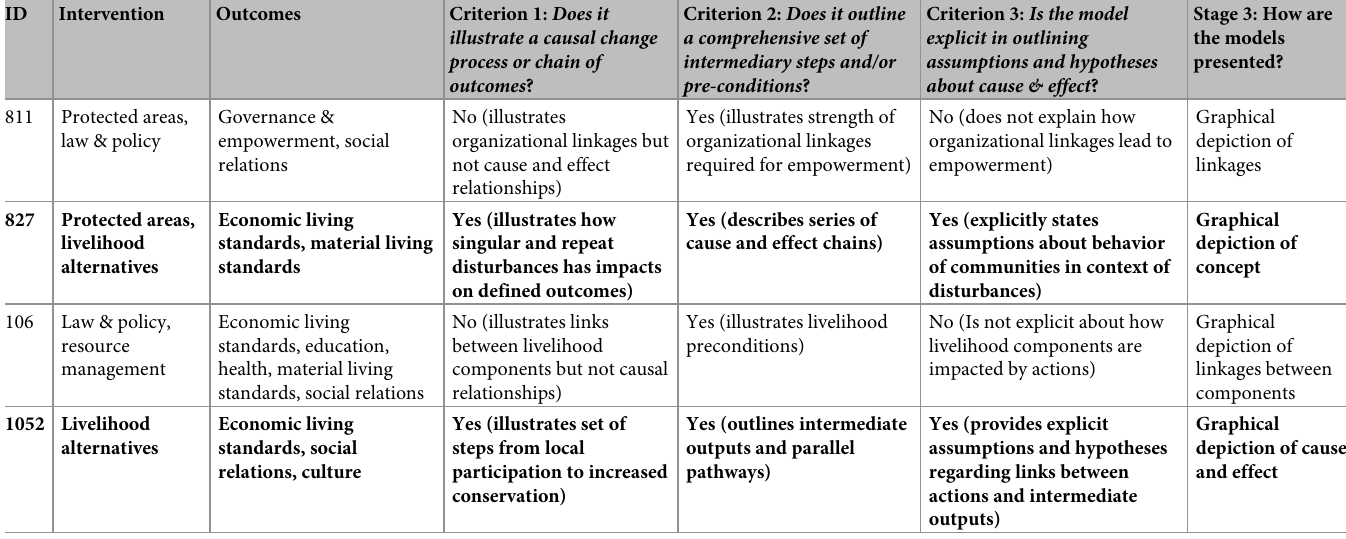
Table 3. Paired example of credible (bold) and non-credible causal models from the conservation and human well-being evidence